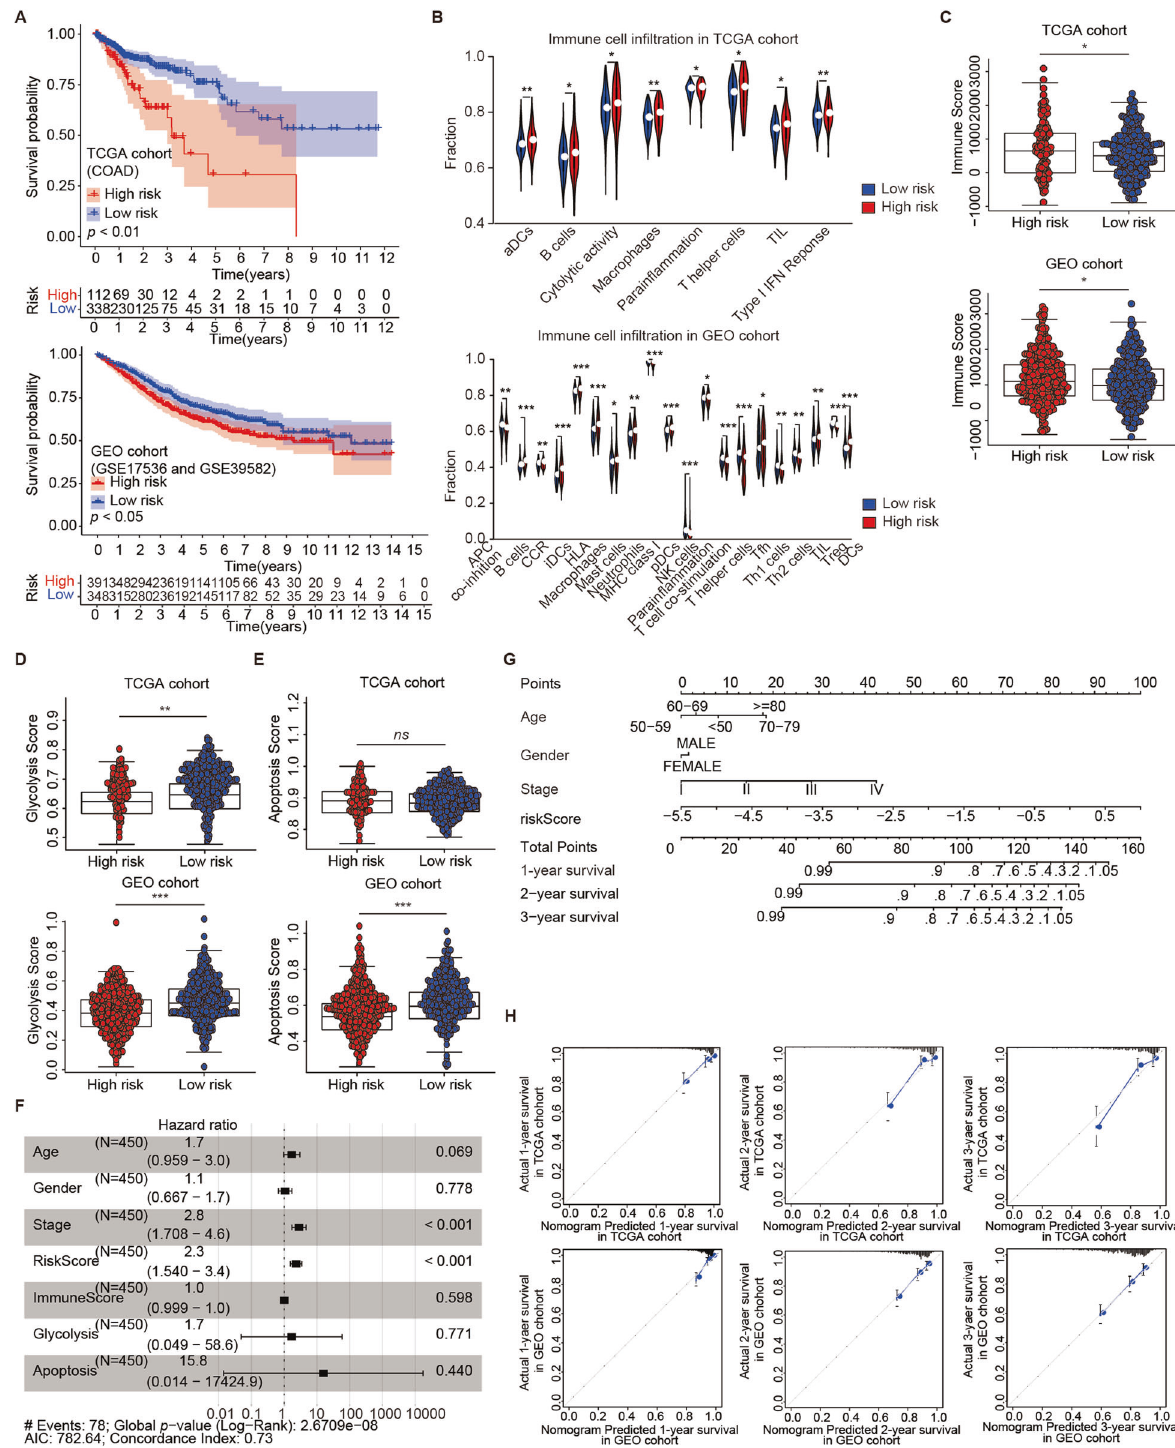
Fig. 4 SLC25 members with high-risk scores are related to the phenotypes of increasing tumor immune in fi ltration and decreasing glycolysis and apoptosis in colon cancer and are involved in a nomogram for survival prediction. A Kaplan – Meier analysis showed that both in the training set from TCGA and validating sets from GSE17536 and GSE39582, patients with high-risk scores had a relatively short OS time. B Clinical cases with high-risk scores showed tumor immune in fi ltration. C Patients in the high-risk group had signi fi cantly higher immune scores than those in the low-risk group. Patients in the high-risk score group had signi fi cantly lower glycolysis ( D ) and apoptosis ( E ) pathway scores. F Risk score represented as an independent risk factor for predicting the prognosis for patients with colon cancer using multivariate Cox regression anand multivariate Cox regression analyses for overall sualysis. G A nomogram including risk scores showed estimates of the prognosis for cases from the TCGA database. H The calibration curve of the nomogram suggested an optimal agreement between the estimated overall survival outcomes at 1 year, 2 years, and 3 years and the actual observed clinical outcomes of the cases from TCGA and GEO datasets. Statistical analysis: Wilcoxon rank-sum test. ns , nonsigni fi cant, * p < 0.05, ** p < 0.01, *** p < 0.001, **** p < 0.0001.